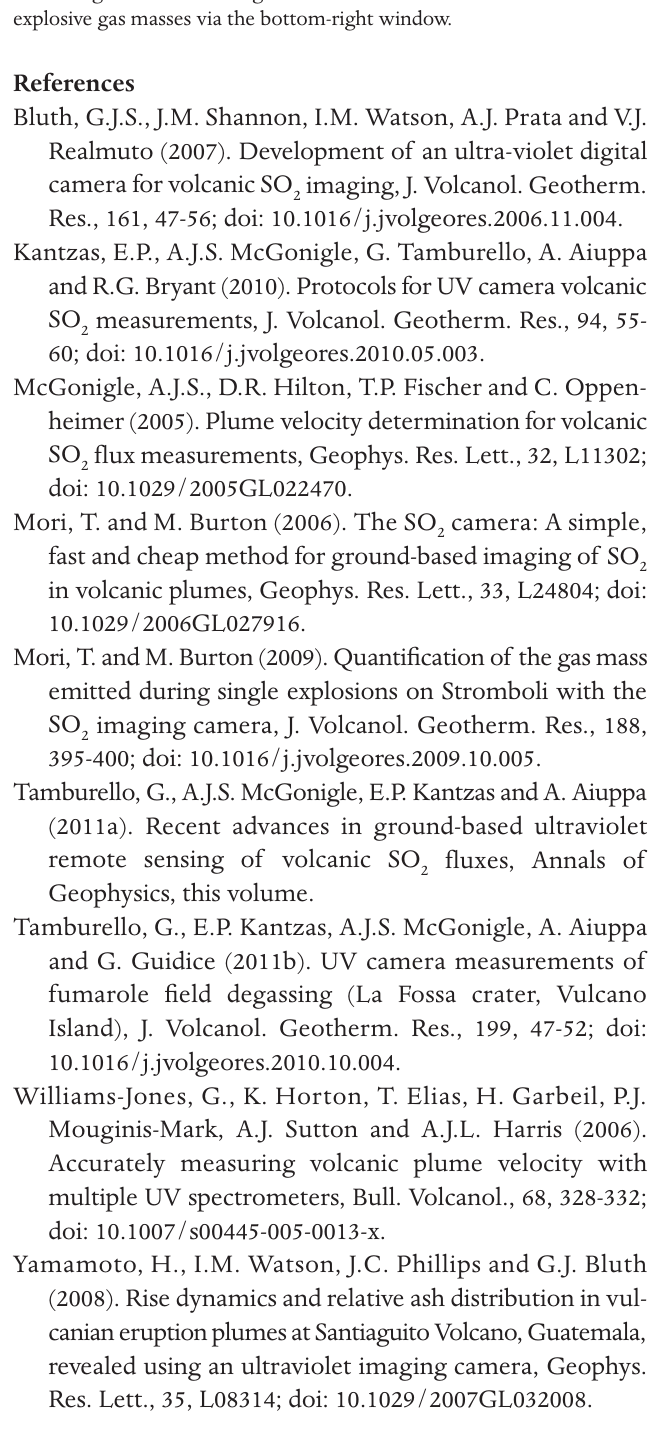
Figure 1 (previous page). Screen shot of the main screen of Vulcamera_post when in operation during the post-processing of volcanic degassing images from Stromboli volcano (Italy). Graph A and Graph B show the raw image files taken from the two cameras, with filters at 310 nm and 330 nm, respectively, showing the gas attenuation in Graph A. These images can be flipped as appropriate and are vignette corrected on the basis of operations that take place on the vignetting page. A profile across the rising gas plume is identified in Graph A using the L and R cursors, the intensities across which are presented in the profiles in the Section graph. The calibration data, as obtained from the calibration page, are entered into the appropriate fields to the centre-right of the screen, to generate both the pseudocolor graph of the concentrations across the images shown in the top right, and the concentrations across the L-R profiles in the Section ppm m/absorbance field. All of the above are then used to generate the integrated column amount time series of the explosive gas masses via the bottom-right